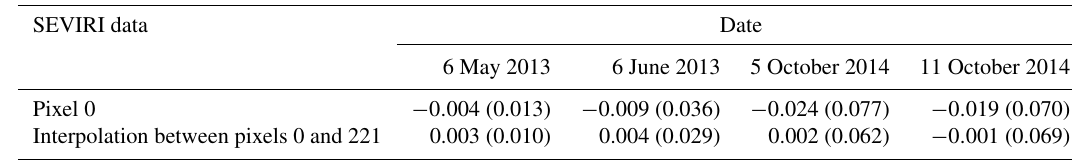
Table 4. The bias (HATPRO minus SEVIRI) and rms difference (shown in brackets) between the LWP values derived from satellite and ground-based observations (kgm − 2 ) for the cases shown in Fig. 8.